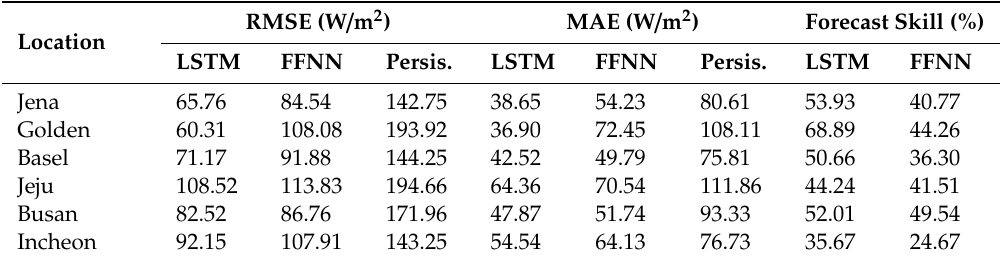
Table 6. Performance evaluation of the proposed